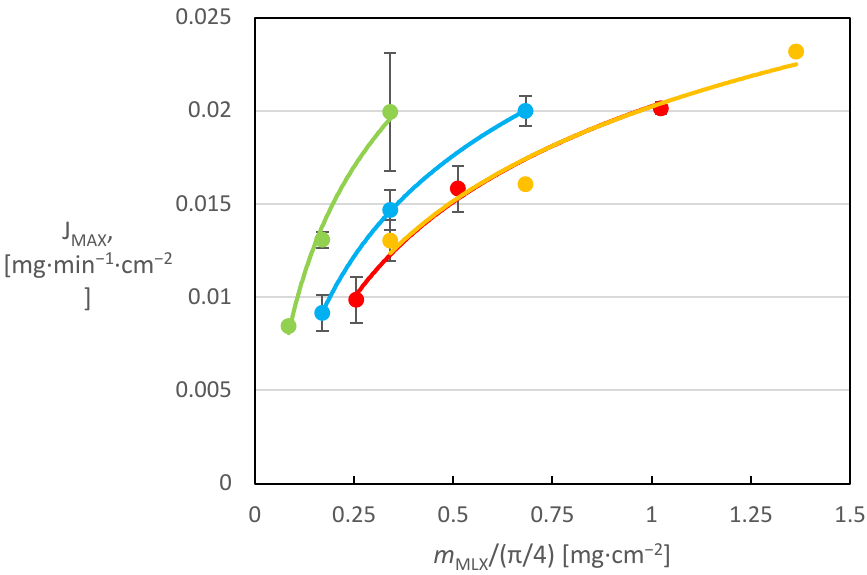
Figure 4. Maximum MX release flux depending on carrier surface coverage by MX (5 drops ■ , 10 drops ■ , 15 drops ■ , 20 drops ■ ); the curves fit the data by logarithmic functions.